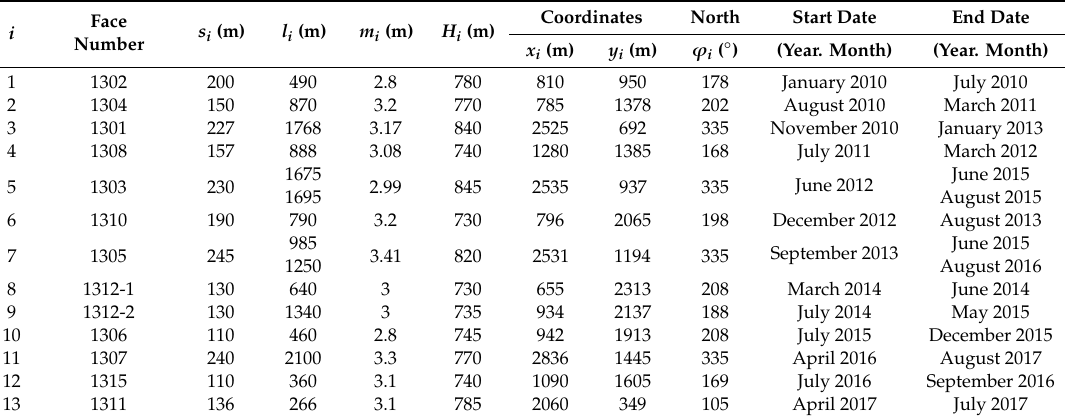
Figure 5. The mine working face layout. Table 3. Calculation parameters of the working faces and main shaft